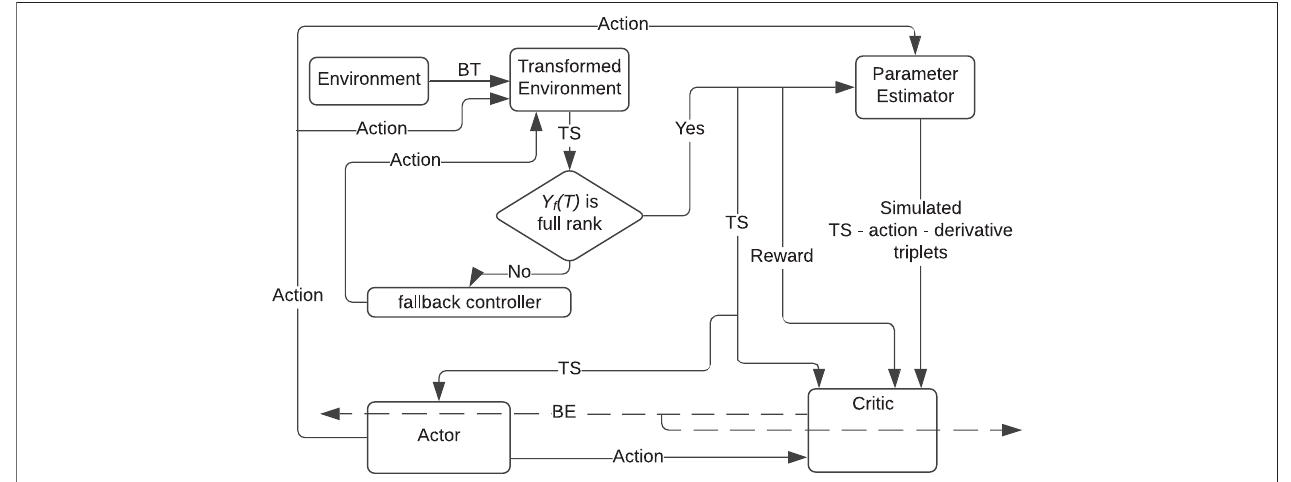
FIGURE 1 | The developed BT MBRL framework. The control system consists of a model-based barrier-actor-critic-estimator architecture. In addition to the transformedstate-actionmeasurements,thecriticalsoutilizesstates,actions,andthecorrespondingstatederivatives,evaluatedatarbitrarilyselectedpointsinthestate space, to learn the value function. In the fi gure, BT: Barrier Transformation; TS: Transformed State; BE: Bellman Error.